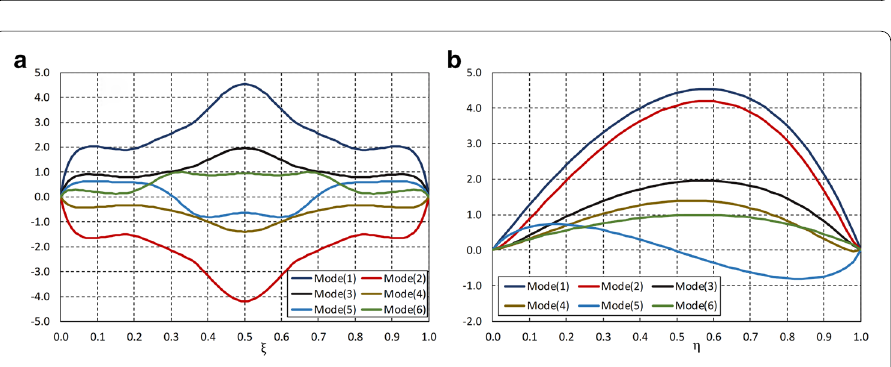
Fig. 6 NURBS surface in 2D and its control net ( a ), single mode SAR ( b ); and two modes SAR ( c )